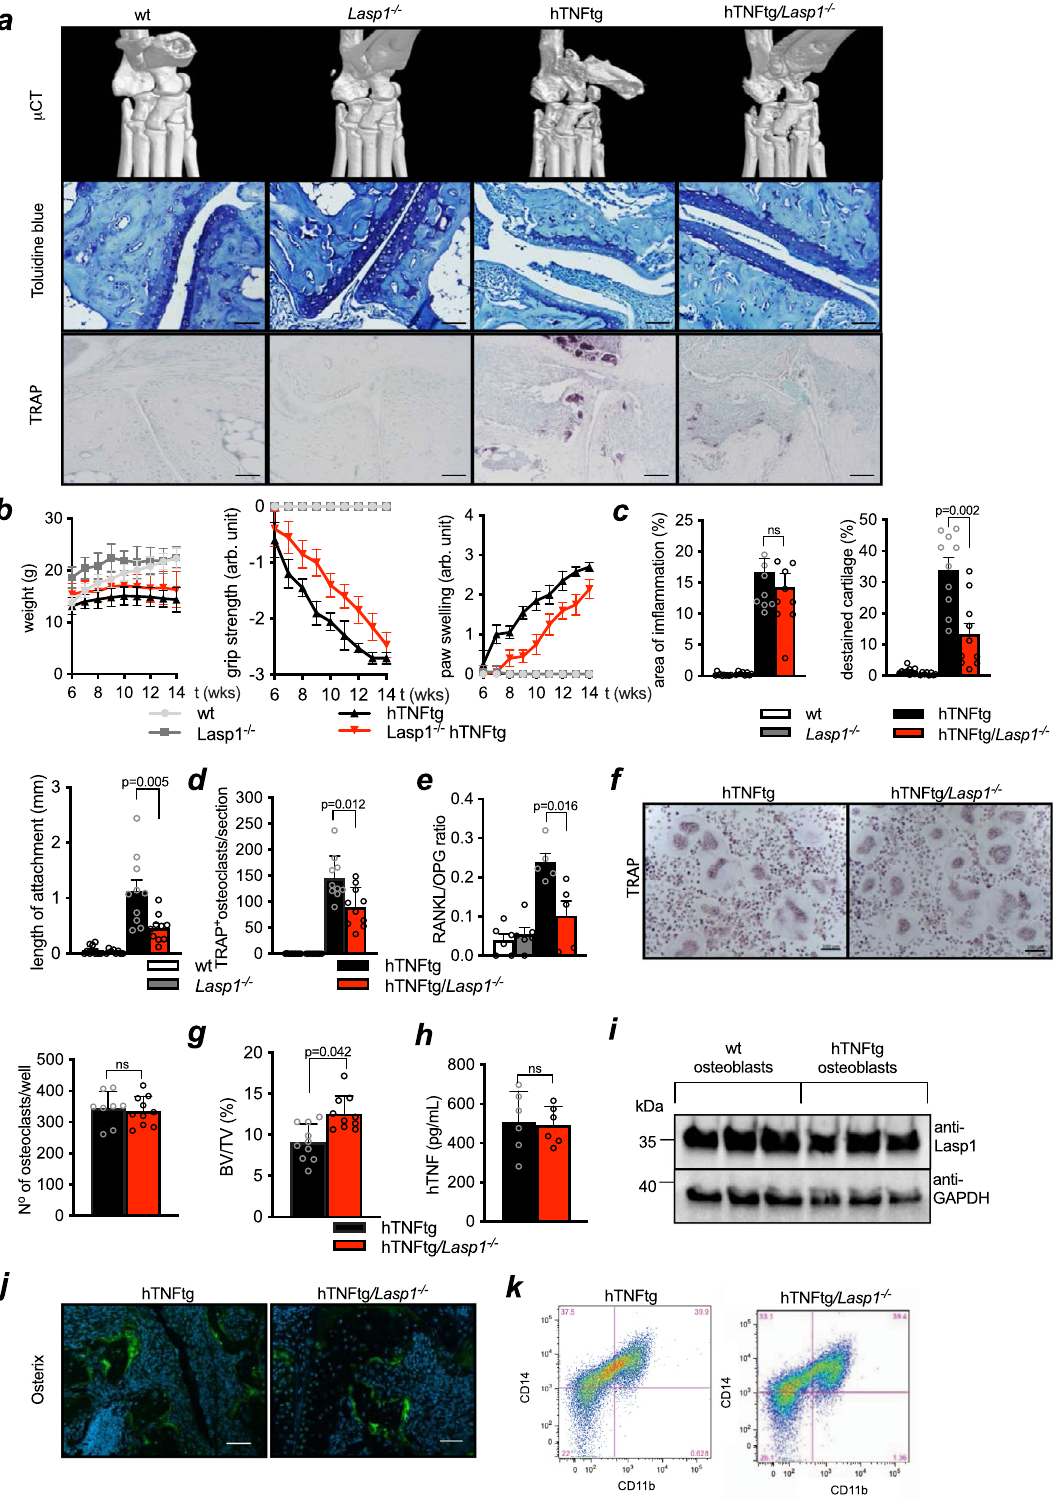
Electric cell/substrate impedance sensing assay . FLS were seeded in ECIS arrays with FCS-supplemented DMEM until 80% con fl uence. A typical electric cell/ substrate impedance sensing assay (ECIS) array consists of 10 active in parallel working electrodes and a counter electrode much bigger in surface area. A non- invasive alternating current (<1 μ A) is applied to the electrodes. ECIS detects the associated voltage drop across the system and determines the electrical resistance of the cell-covered electrodes 49 .